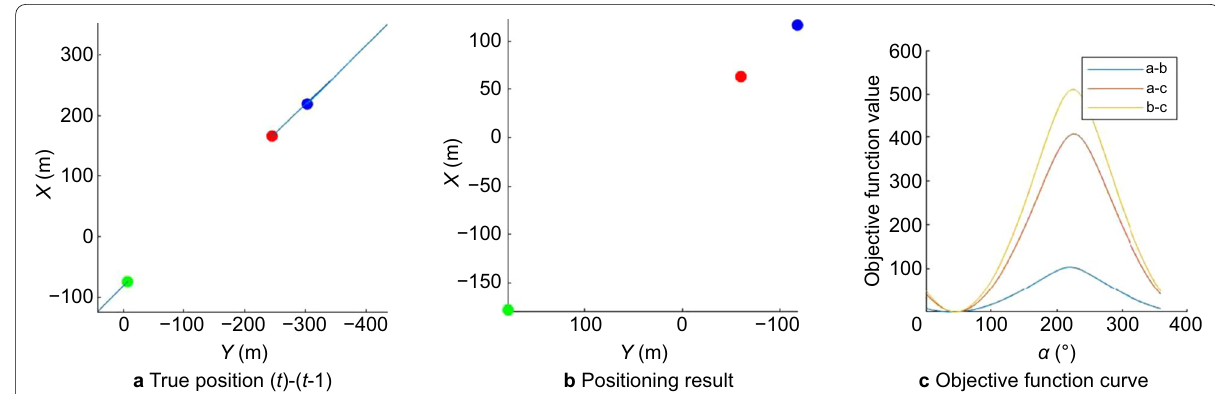
Fig. 12 Colinear formation (non-constant velocity) scenario, simulation results at time t = 1